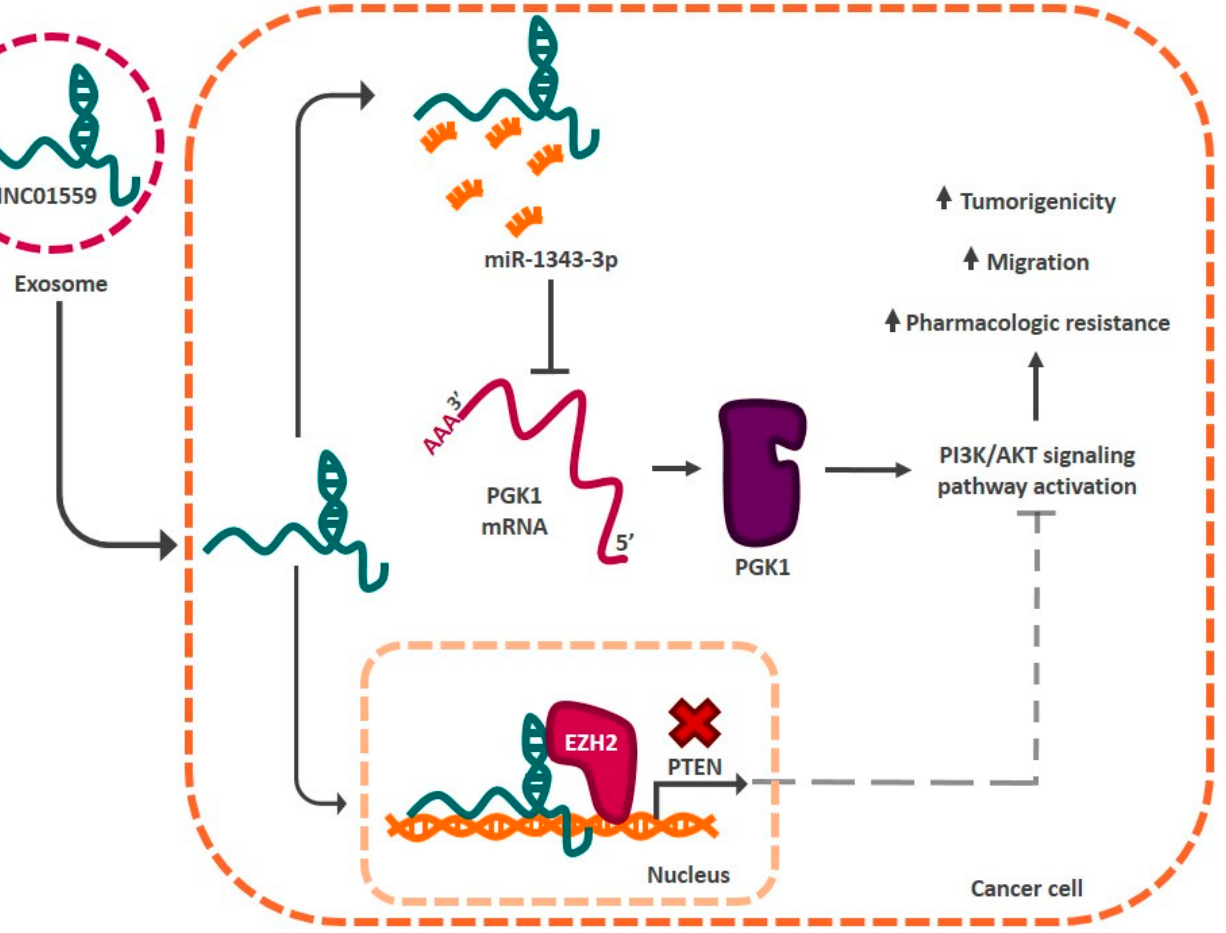
Figure 5. The tumor microenvironment influences the activation of stemness regulatory lncRNAs in gastric cancer. LncRNAs, such as LINC01559, can be secreted by cells in the microenvironment via exosomes. LINC01559 enters cancer cells and activates the PI3K/AKT signaling pathway. There, it acts as a sponge for miR-1343-3p, allowing the translation of PGK1 kinase mRNA and activating the signaling pathway. In addition, this lncRNA acts as a signal to recruit chromatin remodeling complexes to the PTEN promoter region, preventing its expression. This allows the signaling system to be activated and the cancer cells to acquire capacities associated with the stem